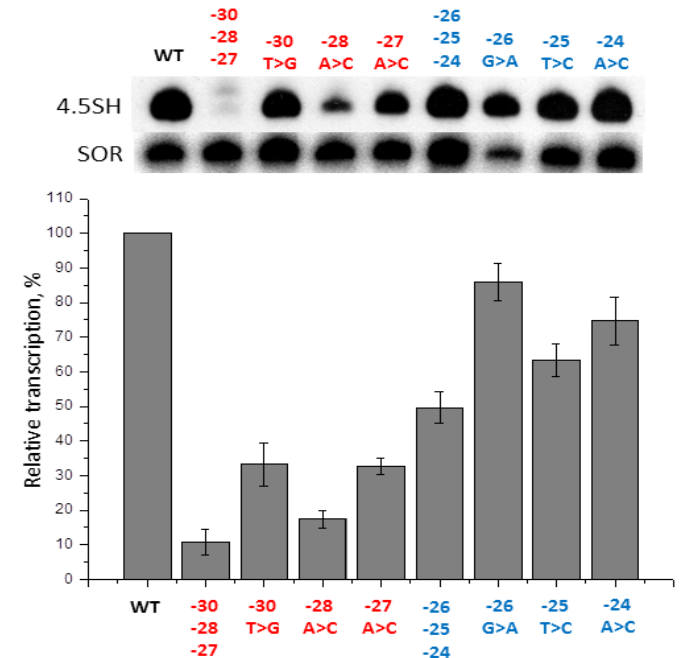
Figure 4. Amplification of the e ff ect caused by nucleotide substitutions in − 31 / − 24 box of 4.5SH RNA gene. Upper panel: 4.5SH-gene transcripts detected by Northern hybridization in cells transfected by constructs, with substitutions of one or three nucleotides in the left ( − 30, − 28, − 27) and in the right ( − 26, − 25, − 24) halves of the box. Substitutions and their positions are indicated above the lanes. Lower panel: quantitative analysis of the Northern hybridization data. The level of gene transcription without nucleotide substitutions (WT) is taken as 100% (error bars, SD, n = 3).